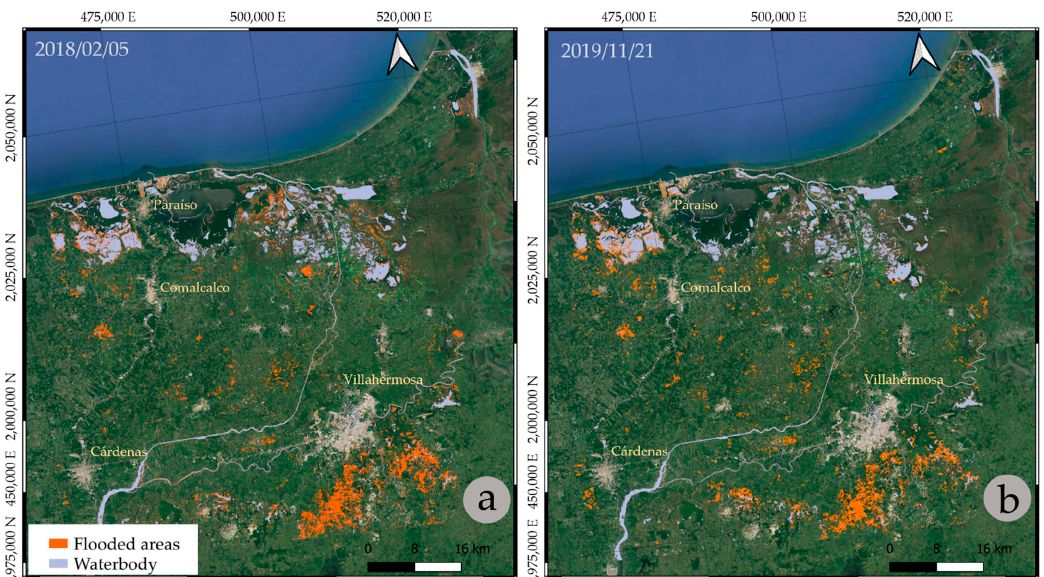
Figure 11. Areas affected by the flood events of ( a ) 5 February 2018 and ( b ) 21 November 2019. Permanent water bodies are shown. A digital globe image is used as a background, the background image was taken from QGIS XYZ Tiles (https://mt1.google.com/vt/, accessed on 8 August 2022).